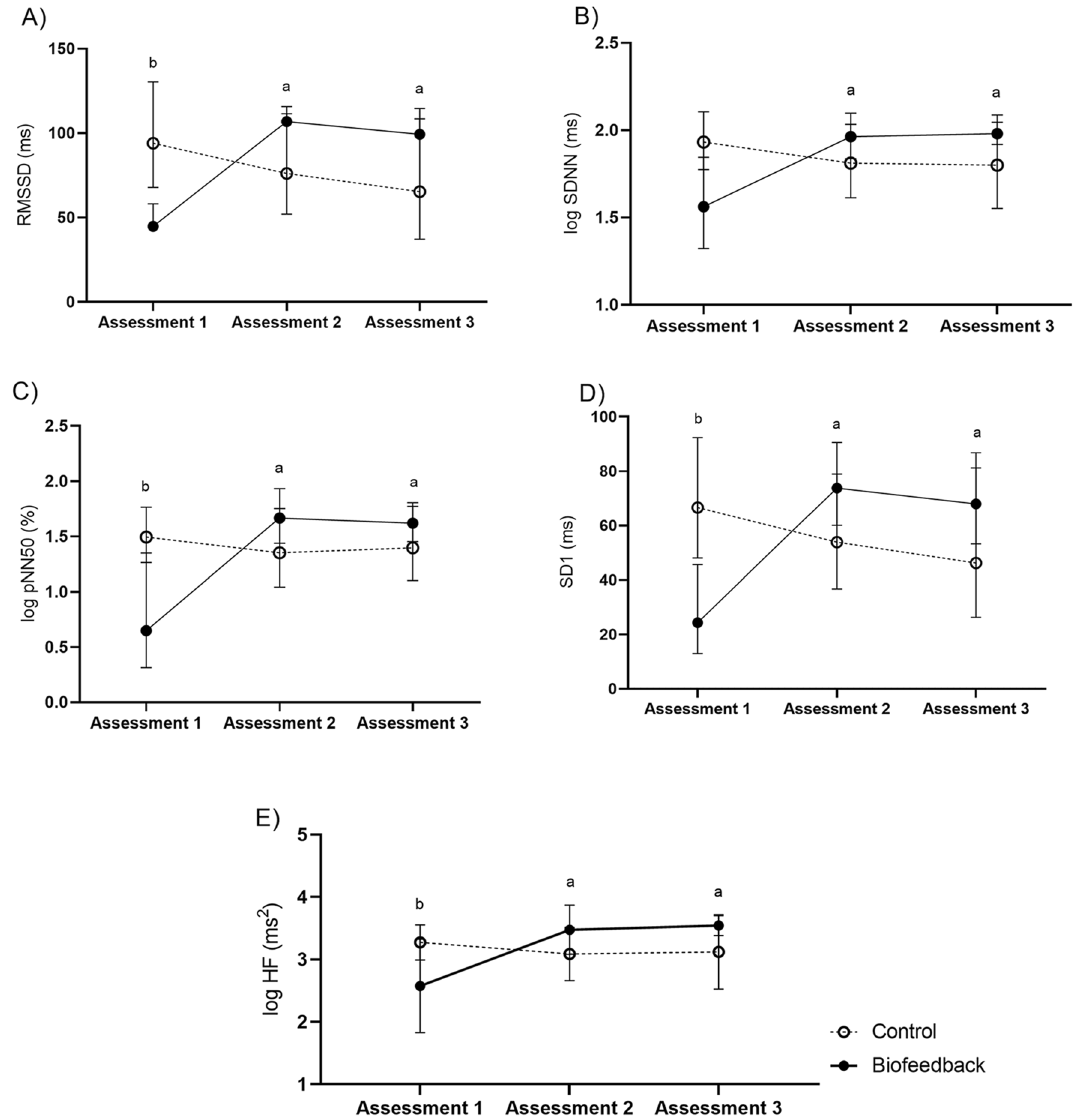
Figure 2. ( A ) Values of the root mean square of the successive differences between the RR intervals (RMSSD) in ms; ( B ) values of logarithmic of the standard deviation of all R-R intervals (log SDNN) in ms; ( C ) values of logarithmic of the percentage of the successive differences between the R-R intervals that are > 50 ms (log pNN50) in ms; ( D ) values of standard deviation 1 (SD1) in ms; ( E ) values of logarithmic of high frequency (log HF) in ms 2 . All these components were evaluated in assessments 1, 2, and 3 in the group that received biofeedback training (solid black line) and in the group that received the control training (black dotted line) in the non-institutionalized sample. a Significant difference of assessment 2 and 3 in comparison to assessment 1 (< 0.05) and b significant differences between groups (<